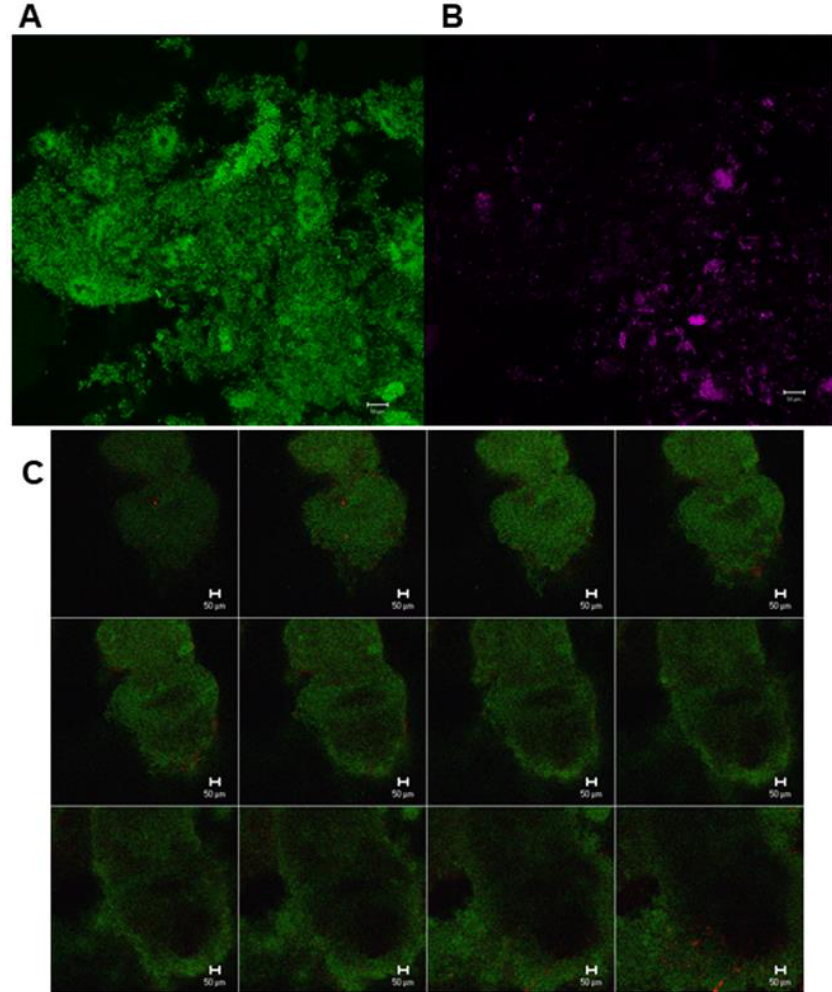
Figure 4. Confocal laser scanning microscopic (CLSM) images from different sections of in situ oral biofilm after the application of fluorescent in situ hybridization with different specific probes. ( A ) Green, eubacteria-specific; ( B ) Streptococcus spp.-specific probe; ( C ) Z-section galleries of representative CLSM images depicting a 3-day old biofilm hybridized with eubacteria-specific (green) and Lactobacillus spp.-specific probe (red).